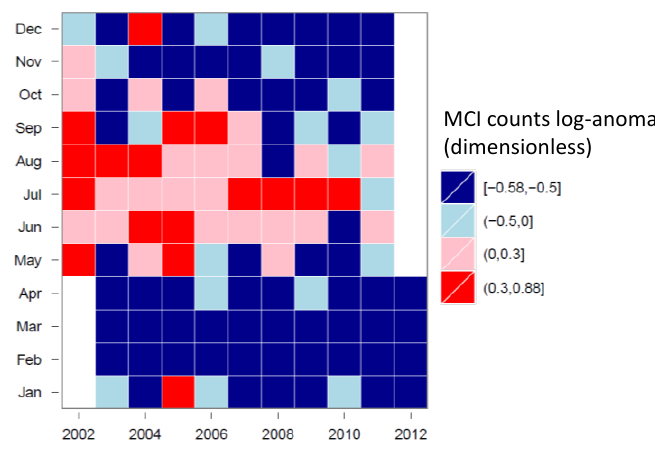
Figure 10. Tile-plot of MCI counts for the GBRW cluster (log-anomalies).